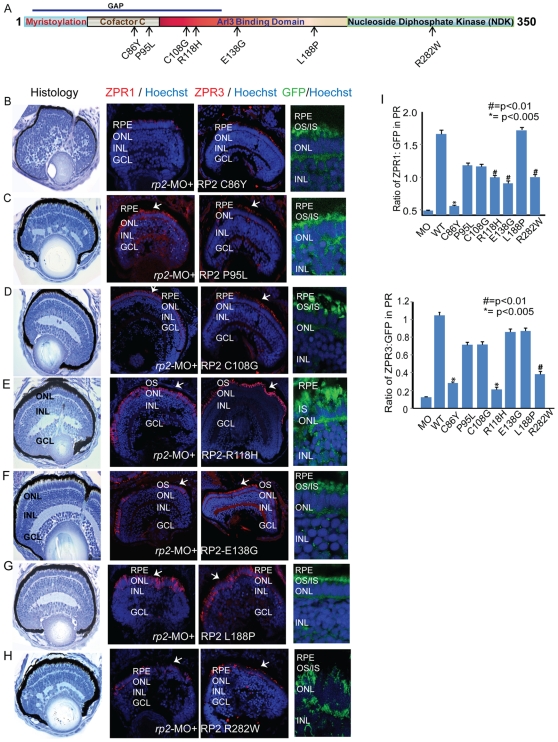
RP2 disease mutations exhibit diverse pathogenic potential.
A. Schematic representation of the primary structure of the RP2 protein and predicted domains. Arrows indicate the mutations tested in this study. GAP: GTPase activating protein domain. B–H. Histological and immunofluorescence analyses (using ZPR1 or ZPR3 antibodies; red; arrows or anti-GFP; green) of retinas of embryos injected with rp2-MO and mRNA encoding indicated RP2 mutant proteins (fused to GFP) was performed as described in the Methods section. Nuclei are stained with Hoechst (blue). RPE: retinal pigmented epithelium; OS: outer segment; IS: inner segment; ONL: outer nuclear layer; INL: inner nuclear layer; GCL: ganglion cell layer. I. Quantitative analysis of ZPR1 and ZPR3 expression in the photoreceptor layer of the different embryos was performed and compared to expression of the WT or mutant RP2-GFP protein. The results are represented as ratio of Zpr1 or Zpr3 expression to the GFP expression in photoreceptors.